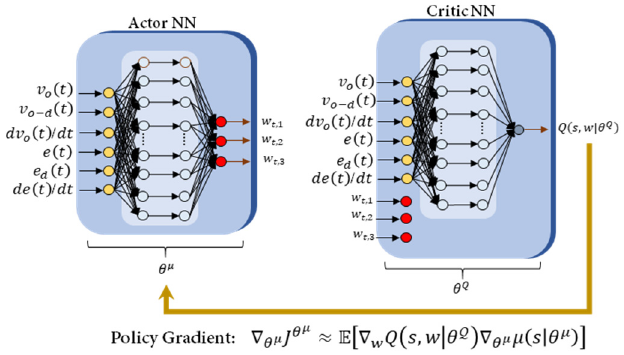
Figure 6. Actor critic framework of the DDPG algorithm.